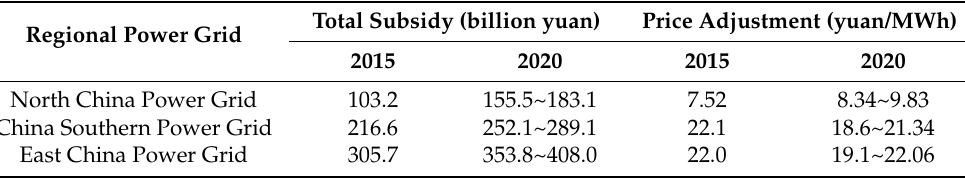
Table 11. NGPG subsidies and feedforward price forecast.